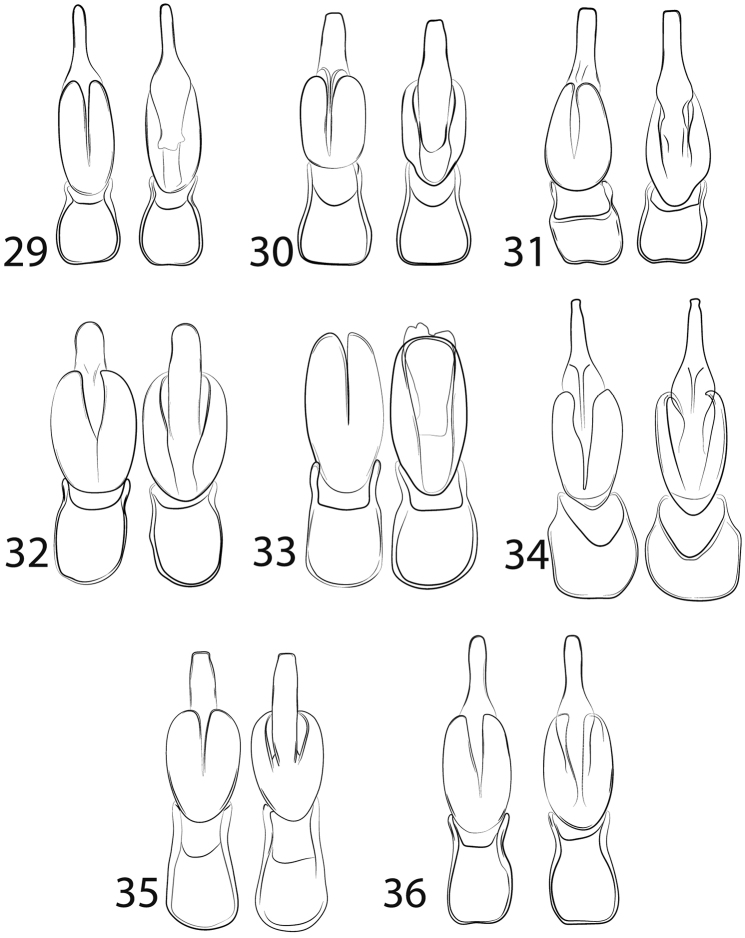
Male genitalia of Lycinella spp. in dorsal and ventral view. 29L.adamantis30L.hansoni31L.milleri32L.cidaoi33L.marshalli34L.opaca35L.parvula36L.pugliesae.